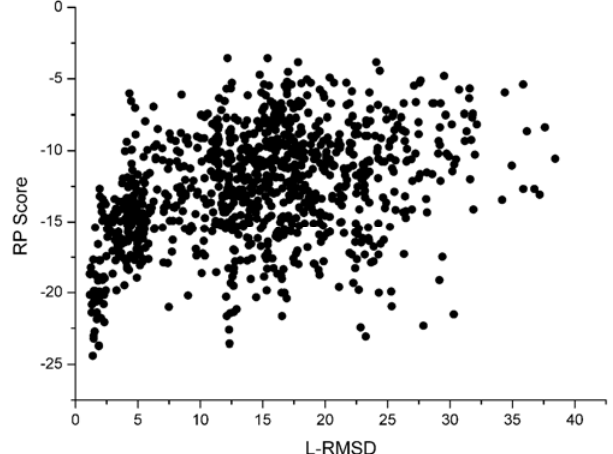
Figure 4. The correlation between the L_RMSD and the RP scoring function (The 1udi was taken as an